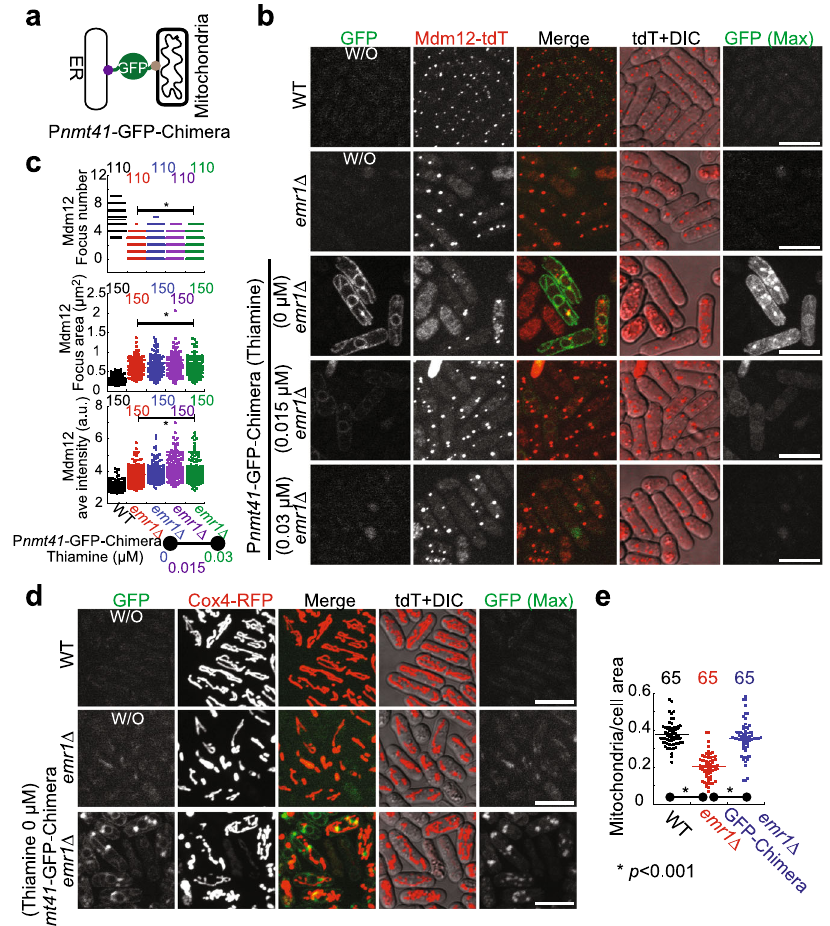
Fig. 7 Tethering mitochondria to the ER partially restores normal mitochondrial morphology but not the number of ERMES foci in emr1 Δ cells. a Diagram illustrating the design of the chimera tether, developed previously 5 . Two domains capable of inserting into the ER membrane and the mitochondrial outer membrane, respectively, are linked by GFP. b Maximum projection images of WT and emr1 Δ cells expressing Mdm12-tdTomato. To assess the effect of the chimera tether on ERMES assembly, the chimera tether was expressed from the nmt41 promoter in media containing 0, 0.015, and 0.03 μ M thiamine (suppression of the tether expression), respectively, in emr1 Δ cells. Note that images in the GFP panel are the middle plane of the respective Z-stack images. The strains that do not express GFP-tagged proteins are marked by W/O. Scale bar, 10 μ m. c Quanti fi cation of Mdm12- tdTomato focus number, area and average intensity, respectively, in the indicated cells in b . Note that expression of the chimera tether does not rescue defective formation of the ERMES complex in emr1 Δ cells. Statistical analysis was performed by one-way ANOVA (focus number: F(4, 545) = 138.60, p < 0.0001; focus area: F(4, 745) = 73.83, p < 0.0001; focus average intensity: F(4, 745) = 88.65, p < 0.0001), followed by Tukey honest signi fi cance difference test (vs. WT; *, p < 0.0001). n indicates cell number observed for quanti fi cation. d Maximum projection images of the indicated cells expressing Cox4-RFP. Cells were cultured in EMM5S media without thiamine. At the bottom panel are the cells expressing the chimera tether. Expression of the tether largely restored normal mitochondrial morphology in emr1 Δ cells. Note that images in the GFP panel are the middle plane of the respective Z-stack images. The strains that do not express GFP-tagged proteins are marked by W/O. Scale bar, 10 μ m. e Quanti fi cation of the ratio of mitochondrial area and cell area. Mitochondrial area increases signi fi cantly in emr1 Δ cell s after ER-mitochondria contacts are rescued with the chimera tether. Statistical analysis was performed by one-way ANOVA (F(2, 192) = 100.10, p < 0.0001), followed by Tukey honest signi fi cance difference test ( emr1 Δ vs. WT and emr1 Δ vs.